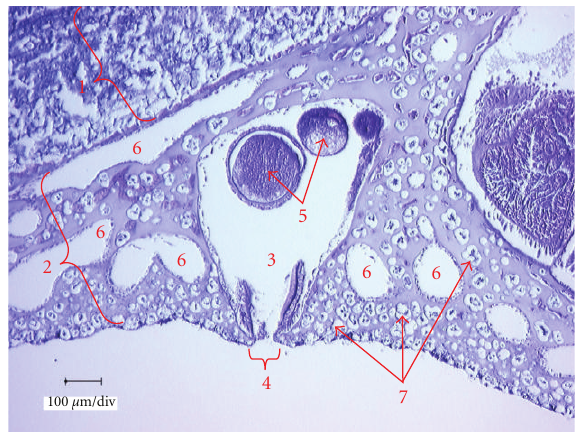
Figure 24: Histological section of Corallium konojoi ; OCA- Cn20090410-032. 1: axis, 2: coenenchyme, 3: siphonozooid, 4: siphonozood opening, 5: gamete (oocyte), 6: vascular canals, 7: sclerite openings.